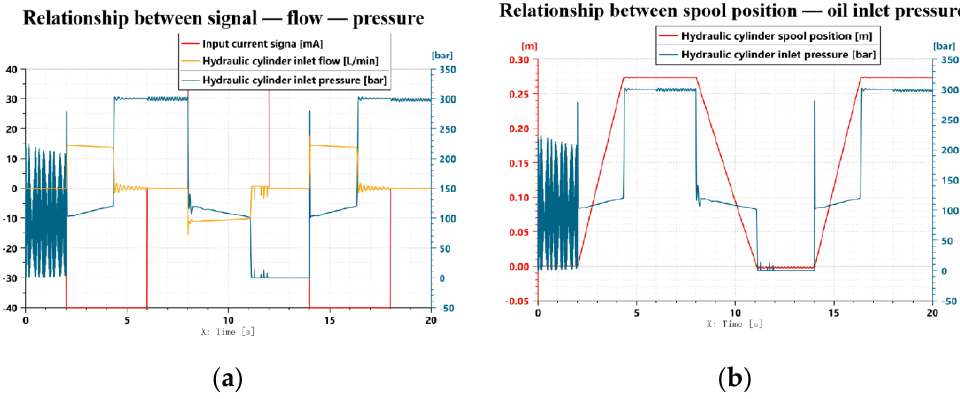
Figure 18. Hydraulic system simulation results. ( b ) Relationship between spool position—oil inlet pressure.